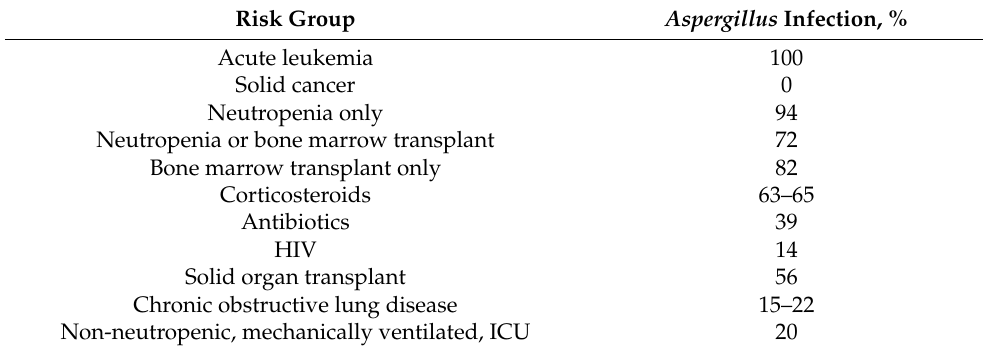
Table 1. Predictive value of positive Aspergillus sputum cultures for invasive aspergillosis. Risk Group Aspergillus Infection, % Acute leukemia 100 Solid cancer